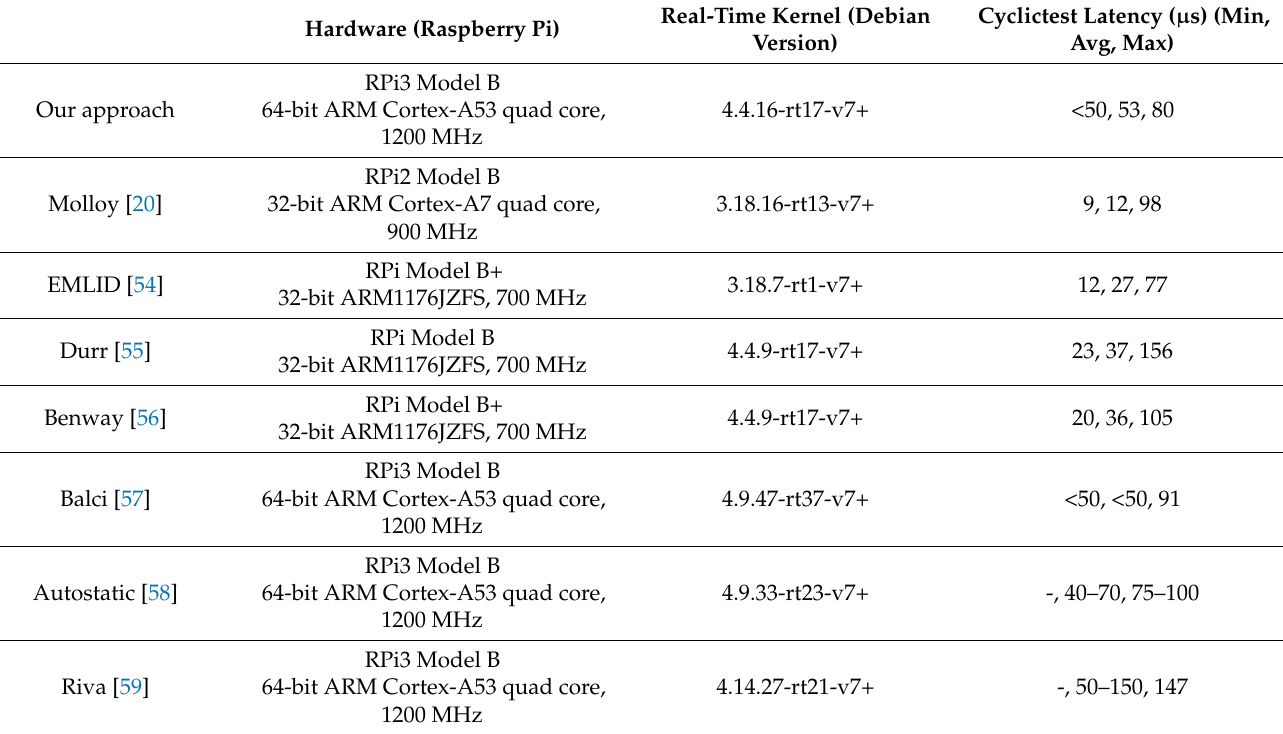
Table 2. Cyclictest latency results comparison for Raspberry Pi with Linux kernels with